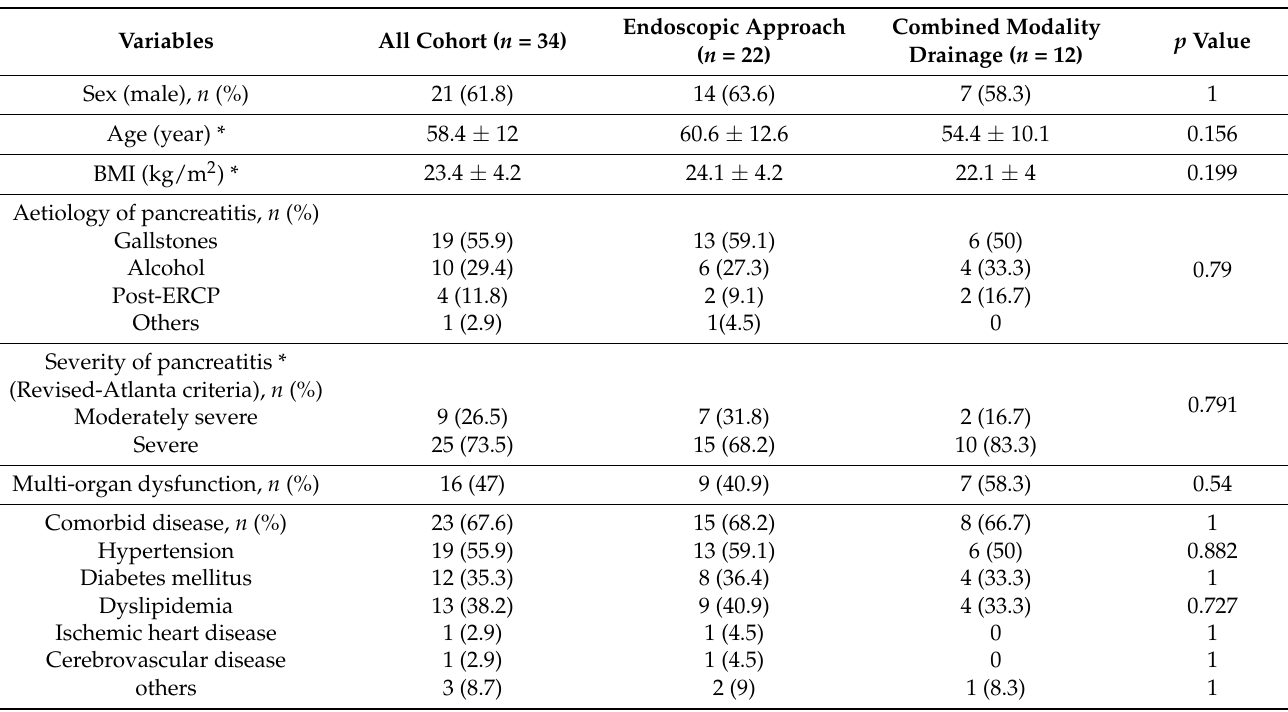
Table 1. Baseline characteristics of the patients in the